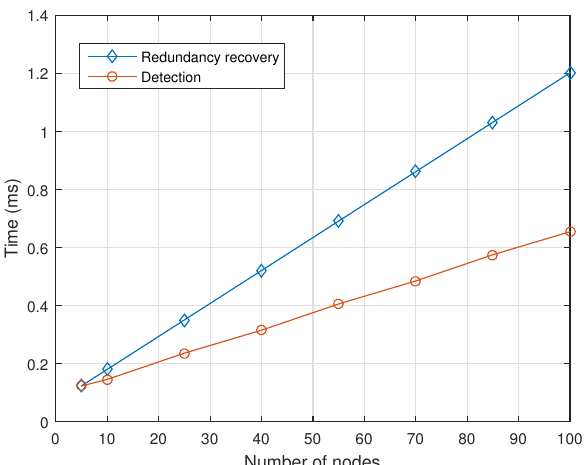
Figure 14. Redundancy Recovery and Detection Times of AeroRing vs the network size.